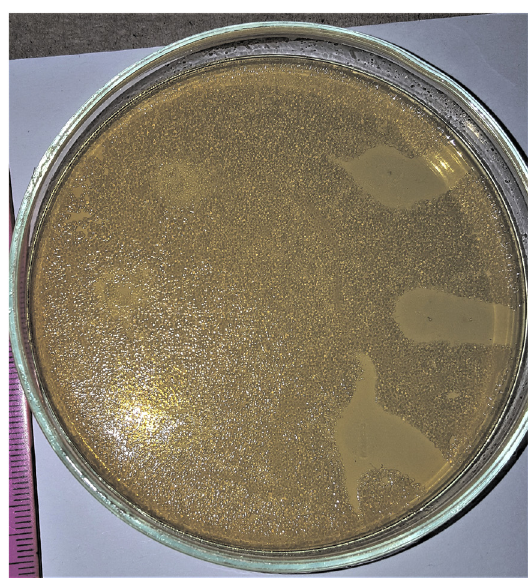
Figure 6. An example of the irregular inhibition halos showed on Mueller-Hinton agar ( Escherichia coli O157:H7) and absence of the disk (6 mm) of the PEC-CAR membrane because of its dissolution. *Triplicate inhibition halos on the right side of plate (PEC-CAR-1.00%) and left side of plate